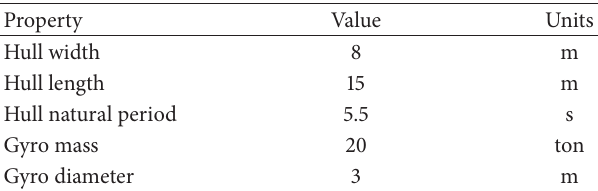
Table 1: Features of the full scale ISWEC